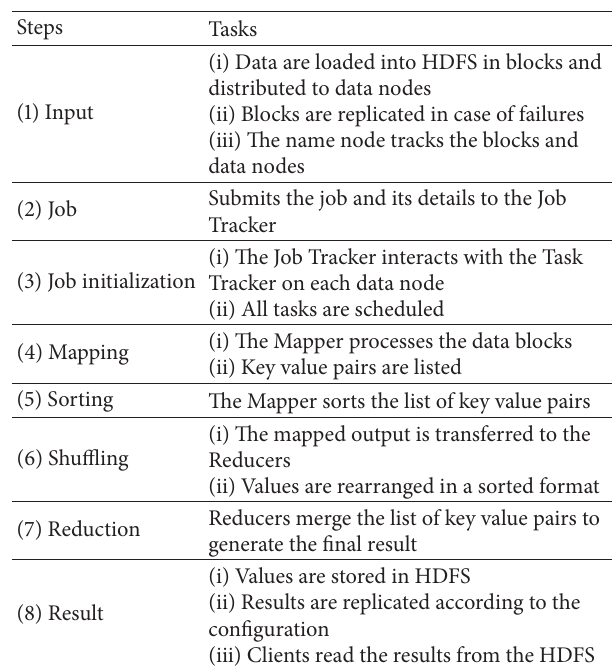
Table 4: MapReduce